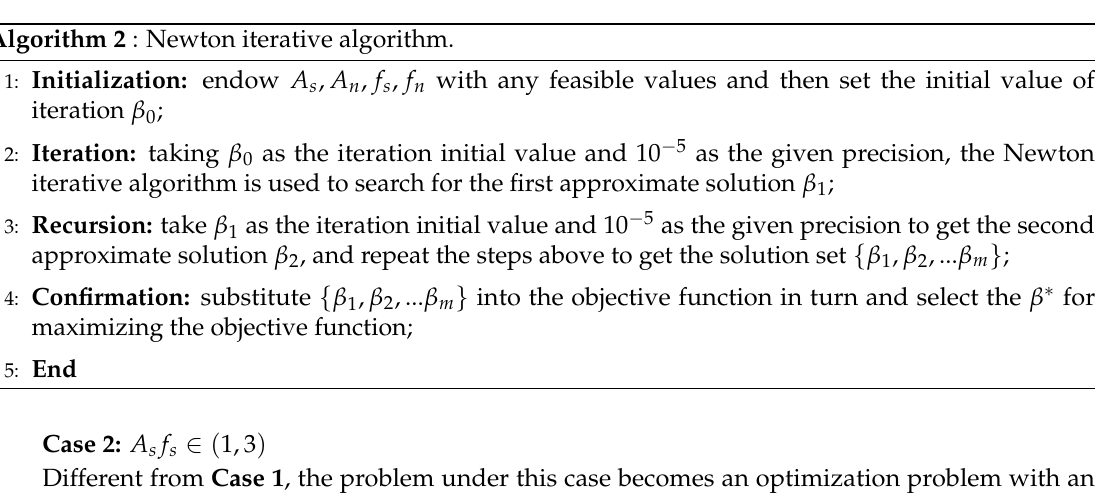
Algorithm 2 : Newton iterative